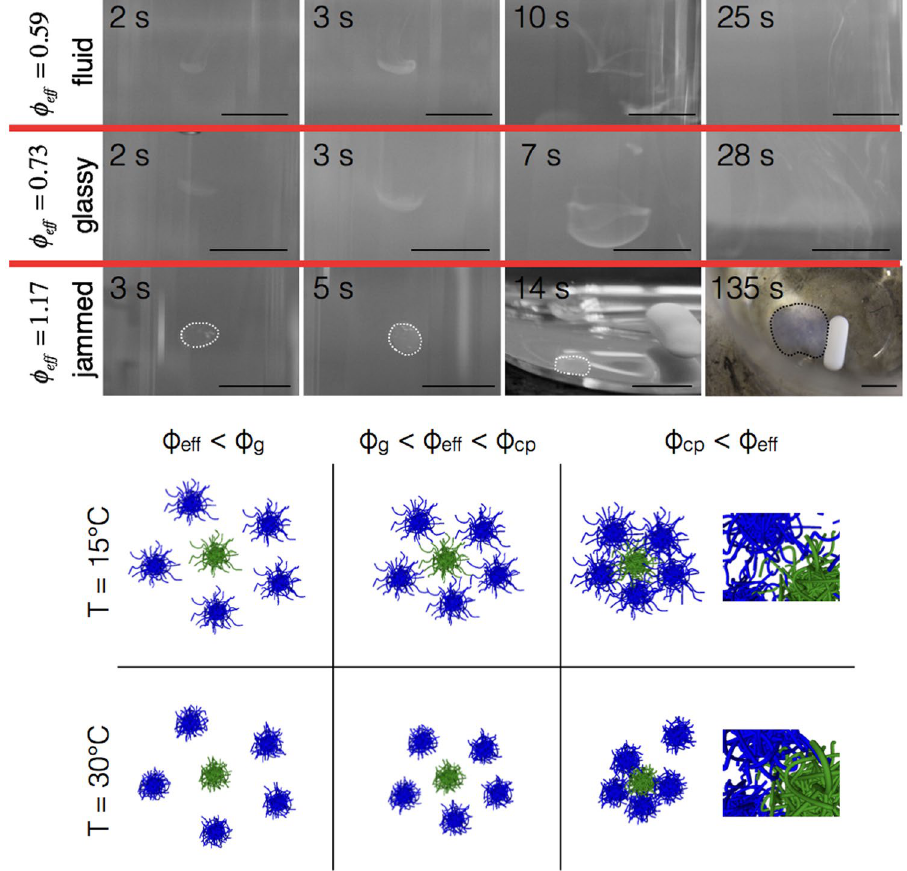
Figure 6. Slow dissolution of jammed samples. Upper panel: Dissolution of a small droplet of a microgel sample equilibrated at T = 15 °C upon injection into a water bath at T = 30 °C. Top row: Initial sample concentration = 0.59. Middle row: Initial sample concentration φ = 0.73. Bottom row: Initial sample concentration φ eff eff = 1.17. Pictures shown were taken at different times after injecting the droplet. Scale bars correspond to φ eff 10 mm. Lower panel: Schematic description of the response of a microgel dispersion to a rapid temperature jump from 15 °C ( T ≪ T VPT ) to 30 °C ( T ≲ T VPT ) at three different volume fractions φ eff < φ g (left), φ g < φ eff < φ cp (middle), and φ eff > φ cp (right), respectively, where φ cp stands for the volume fraction where particles are close packed or jammed and start to significantly interpenetrate. Also shown is a magnified view of the temporary entanglements at φ eff > φ cp (right), which become buried and trapped after the temperature